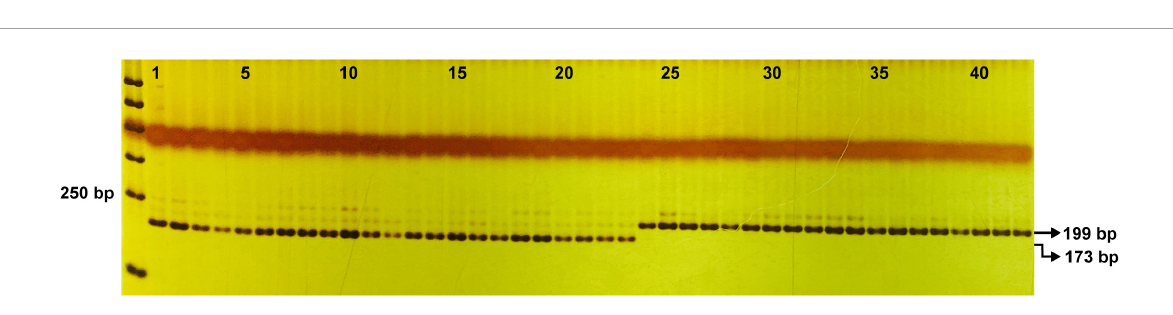
FIGURE6 Validation of the efficiency of dCAPS marker in 42 wax gourd germplasm resources. 1–23, germplasm resources with unilateral seeds; 24–42, germplasm resources with bilateral